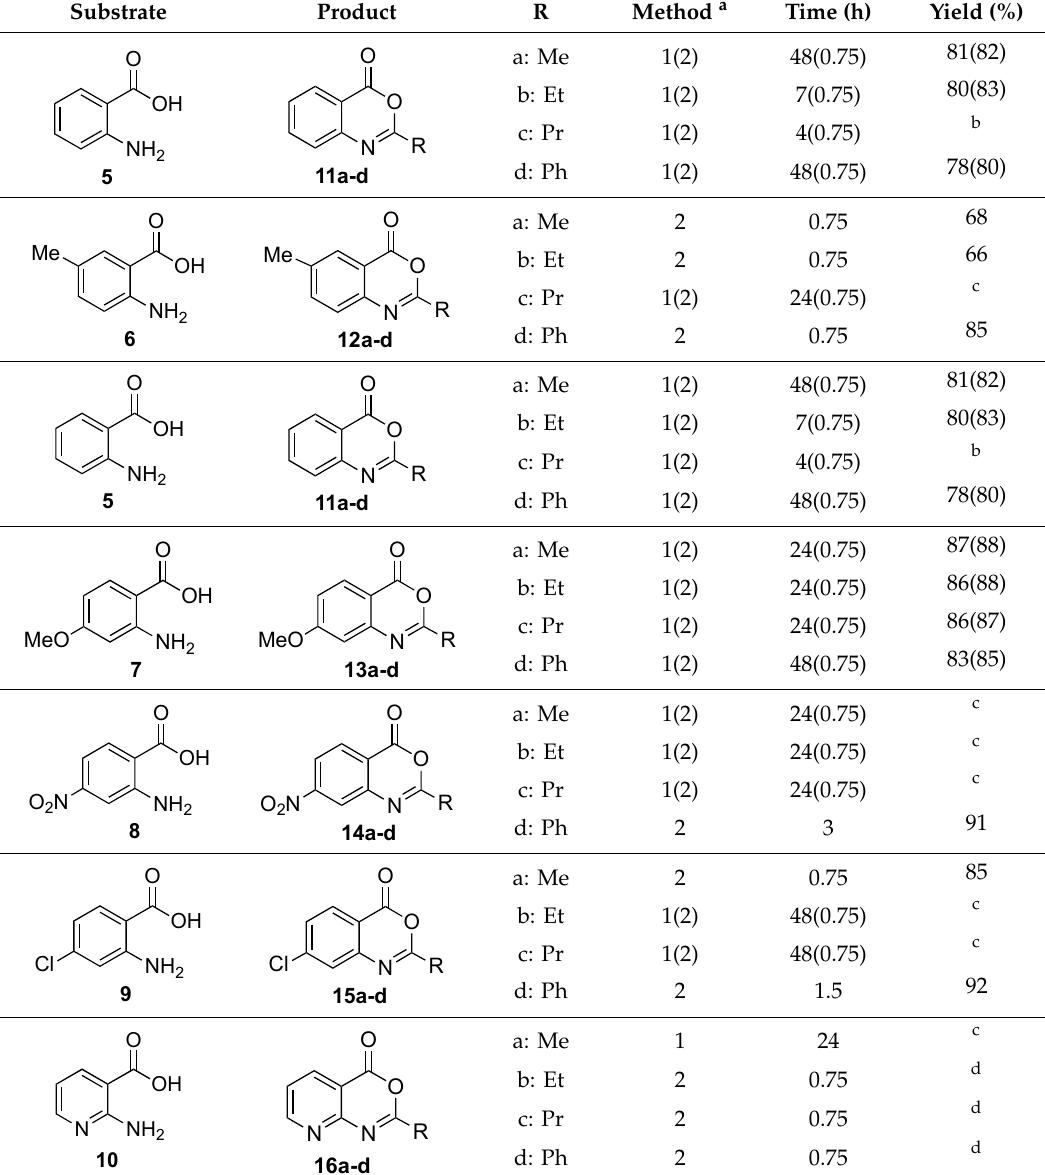
Table 2. Formation of (±)-1,2-dihydro-4 H -benzo[ d ][1,3]oxazin-4-ones.